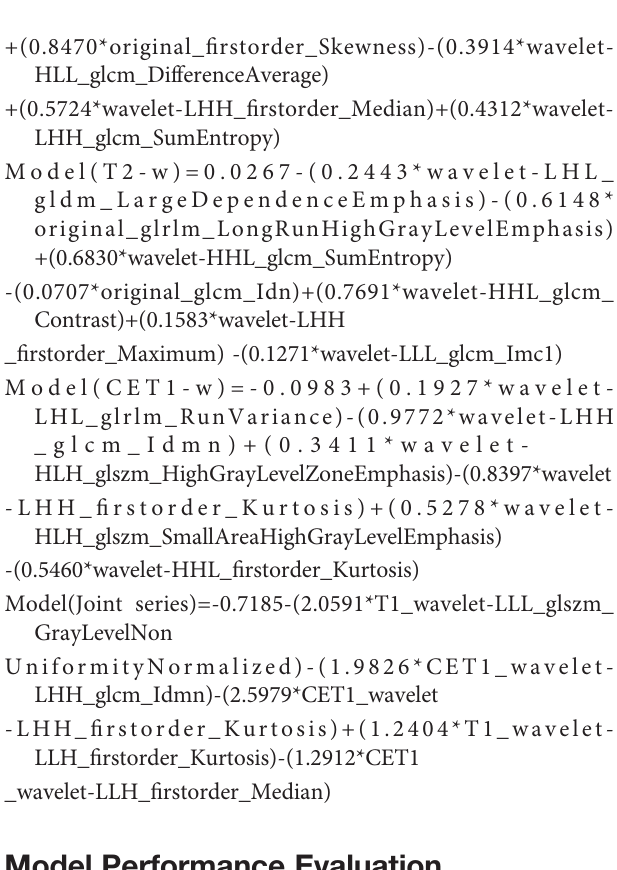
FIGURE 1 | Data acquisition and analysis work fl ow. All patients were divided into treatment-sensitive and treatment-insensitive groups. (A) Pictures a and d showed the original images before treatment, b and e showed the postoperative images acquired within 24 – 72 hours, and c and f showed the postoperative images acquired after approximately 3 months of follow-up. (B) ROIs were de fi ned, and feature extraction, including for fi rst-order, shape-, high-order texture-, and fi lter- based features, was performed. (C) Feature selection, model building and model evaluation were used to predict the response of glioma patients to chemoradiation by multiple logistic regression